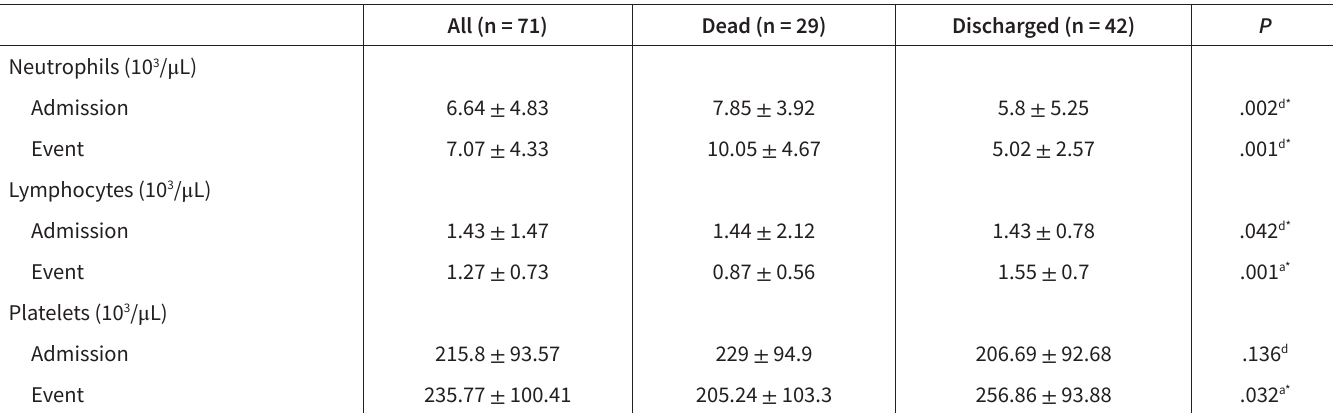
Table 2. Comparison of Patients’ Laboratory Findings Based on Mortality ( Continued